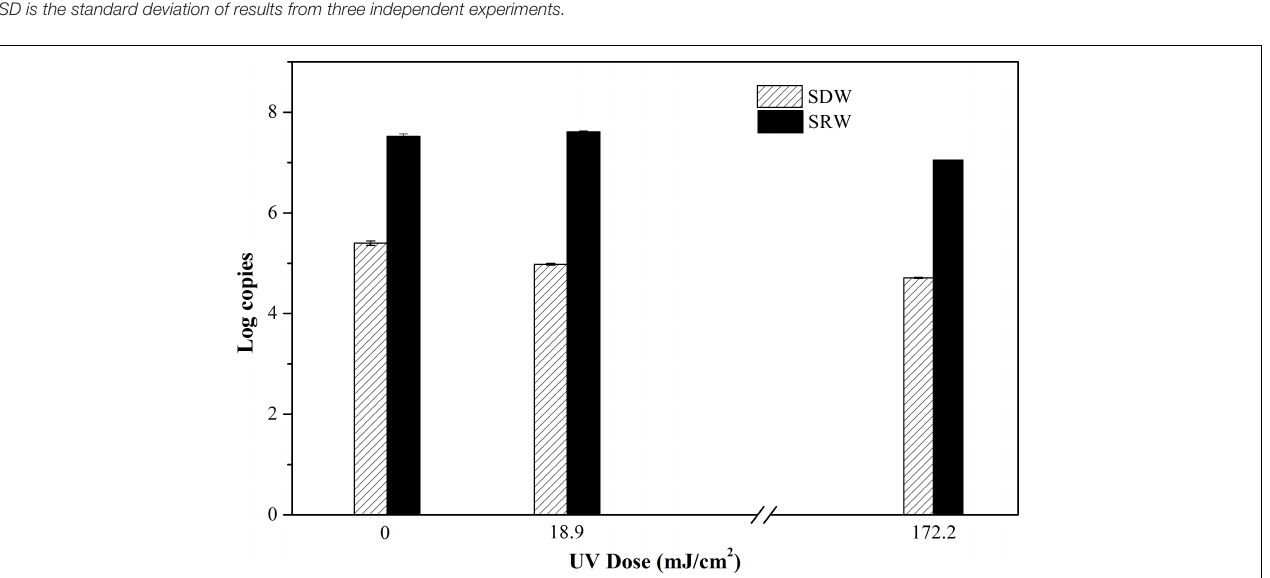
FIGURE 2 | Log copies of 16S rRNA gene quantifying viable cells with integral membrane of E. coli after treatment at UVC doses of 0, 18.9, and 172.2 mJ/cm 2 were determined by propidium monoazide quantitative polymerase chain reaction (PMA-qPCR). Mean values with SD from three independent measurements were shown. SDW, simulated drinking water; SRW, simulated reclaimed